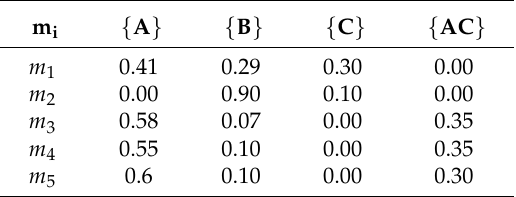
Table 1. The basic probability assignment (BPA) as an